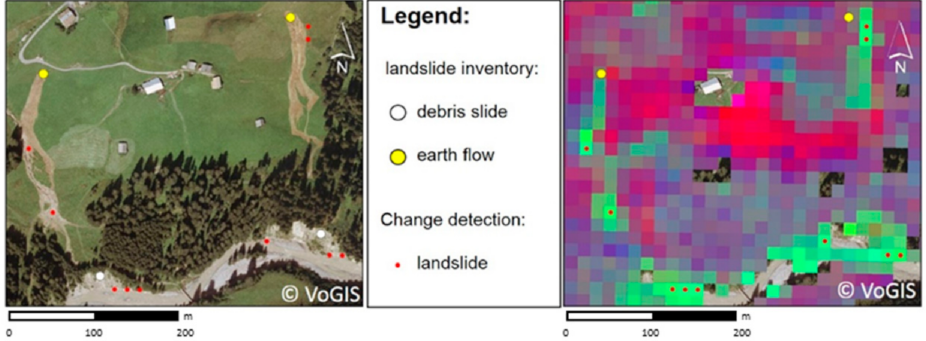
Figure 17. Landslide classification results in the area of Warth-Teschenberg on the river Lech (as seen in Figure